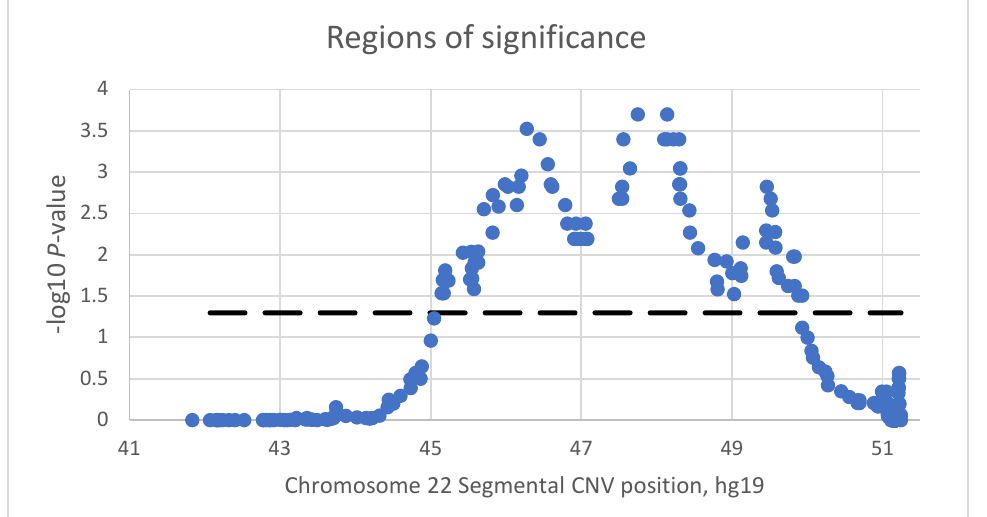
Figure 3. Association between genomic CNV regions on 22q13 and kidney disorders. The dashed line corresponds to a p = 0.05.